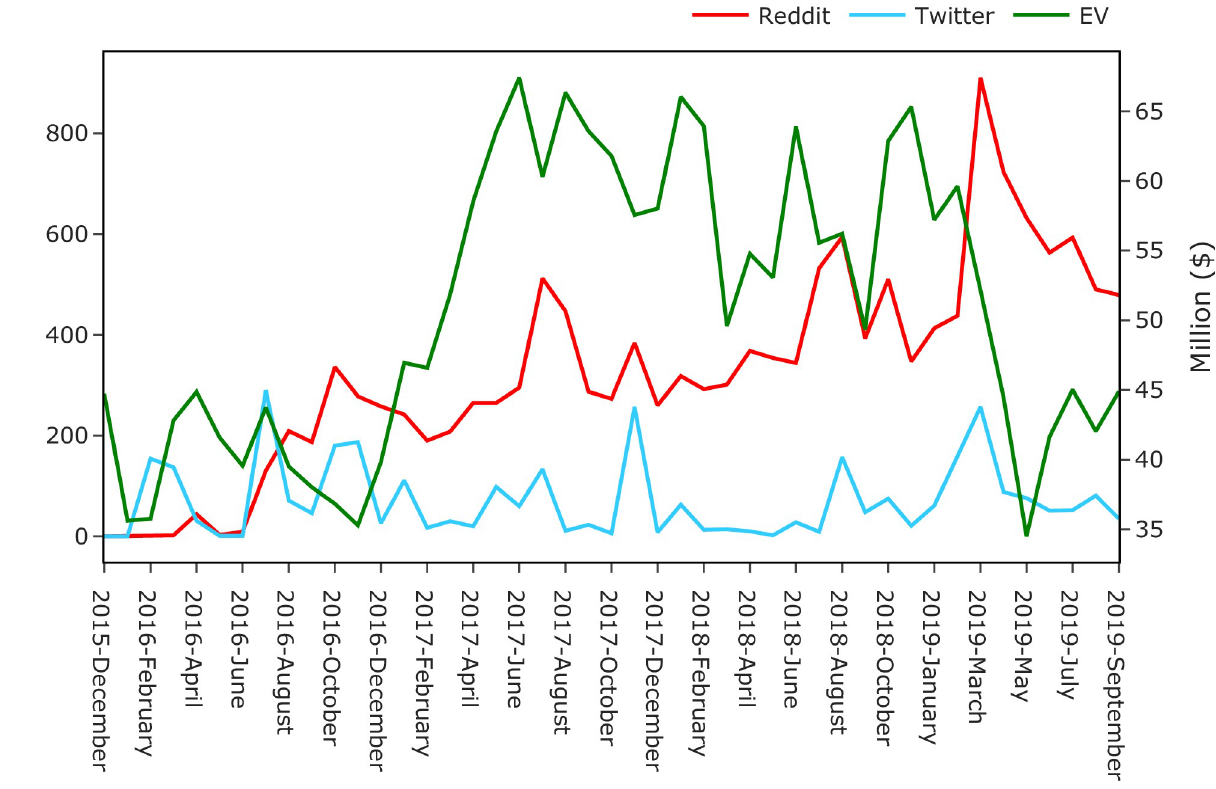
Fig 7. Tesla, Inc (NASDAQ: TSLA): Time-series trends of enterprise value (EV, green line, shown on right y-axis) vs online attention (Reddit, red line, and Twitter blue line, shown on the left y-axis).